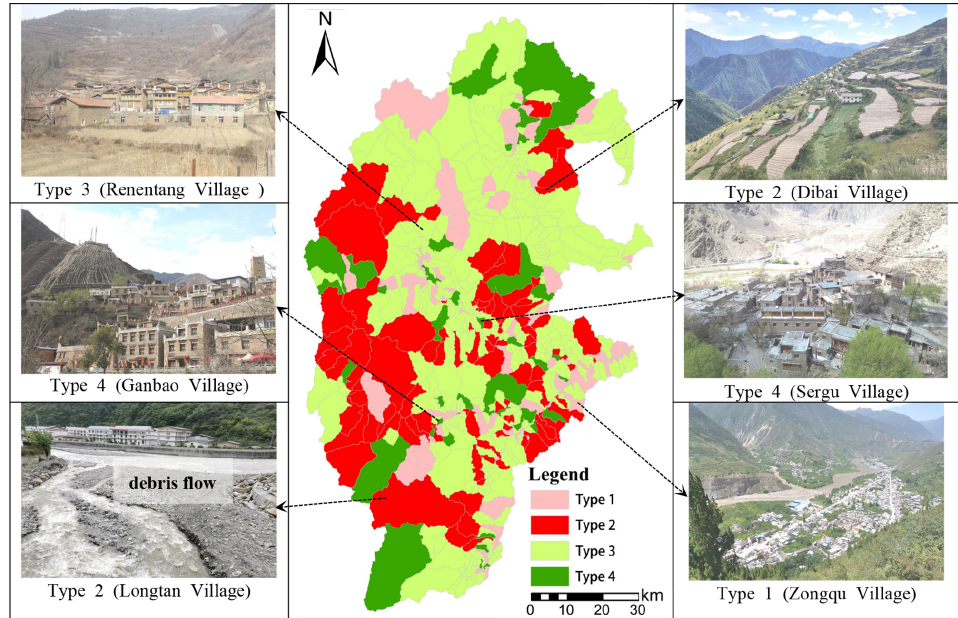
Figure 7. Zoning Diagram of Rural Settlement Optimization Model in the Upper Reaches of the Minjiang River.